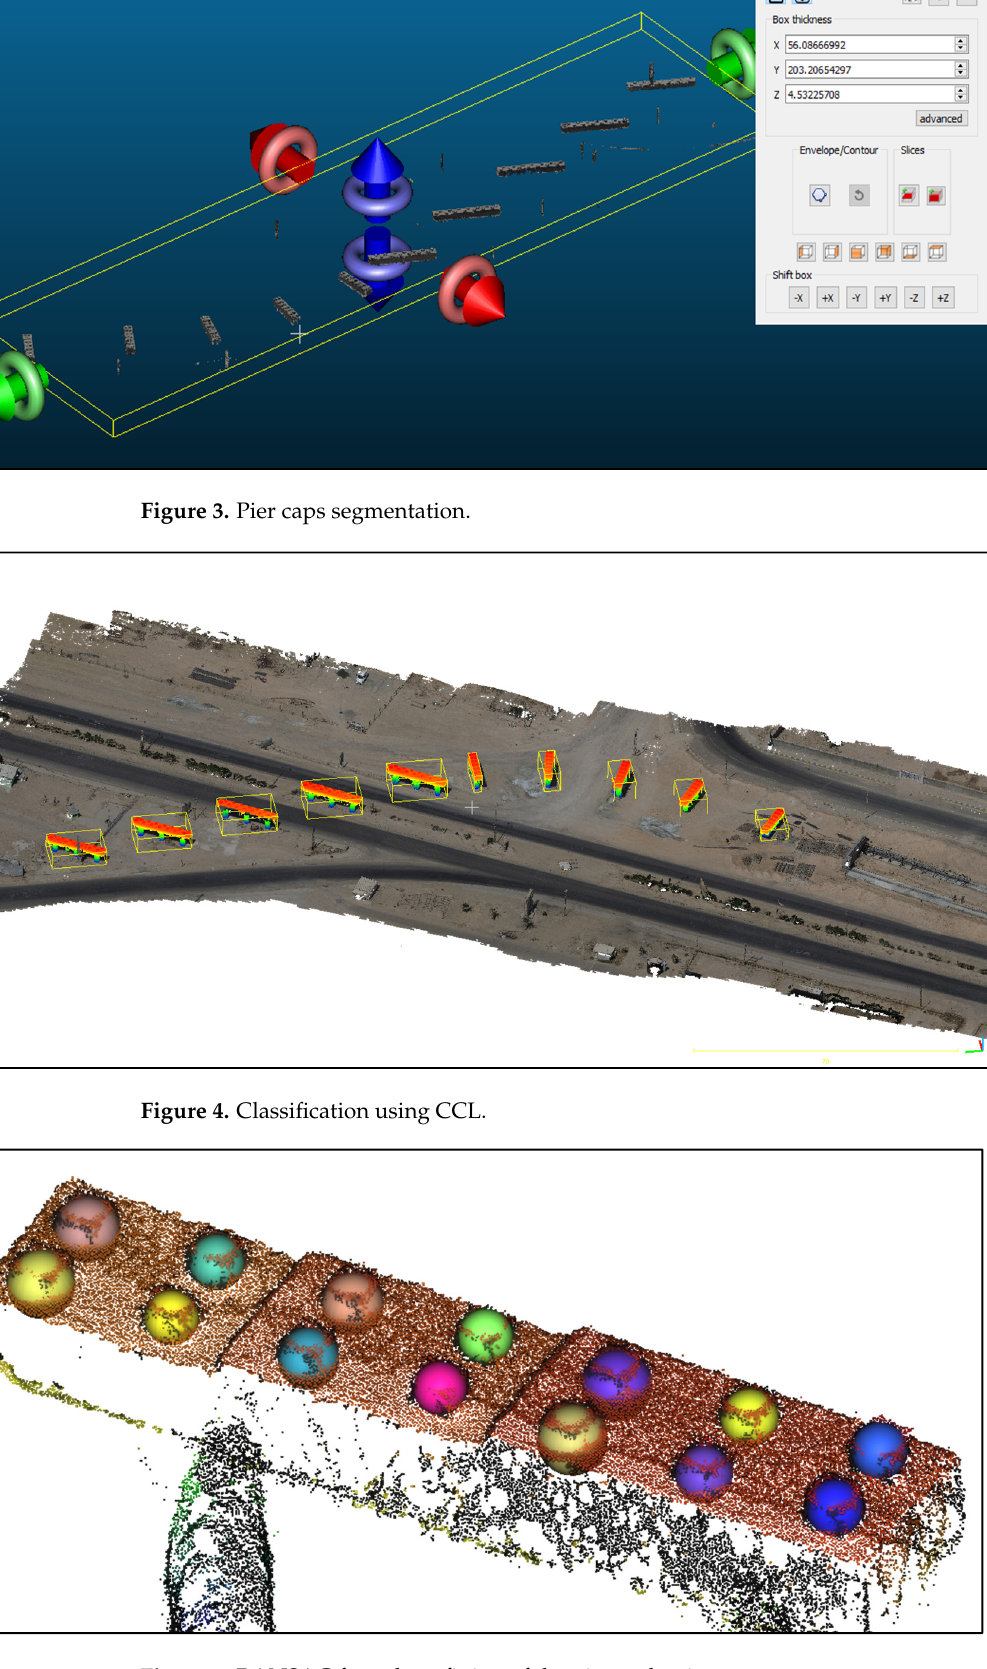
Figure 6. Profile and cross-section creation out of the spheres fitting points. 4. Experimental Tests The proposed method described in Section 3 has been applied in two experiments, one is simulated and one is real, for an ongoing project of the construction of a new over- pass bridge. In both experiments, the consumer-grade DJI Phantom 3 drone was used, which was equipped with FC300X 12 megapixels camera. The camera has a